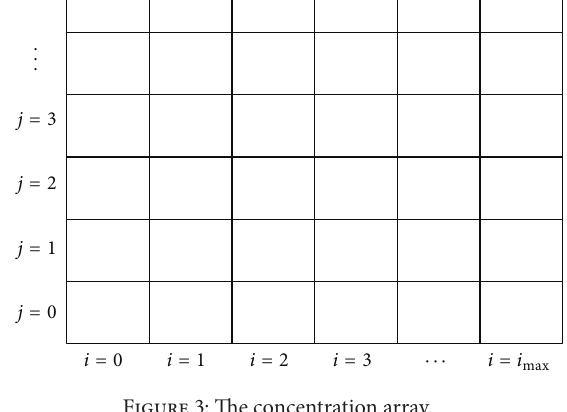
Figure 3: The concentration